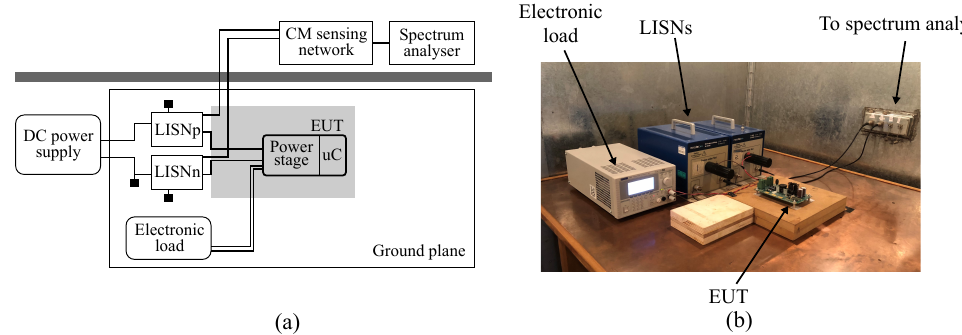
Figure 13. ( a ) Block diagram of the test setup to measure the common-mode EMI delivered by the device under test (DUT), and ( b ) a photograph of the experimental setup compliant with CISPR- 25 standard.